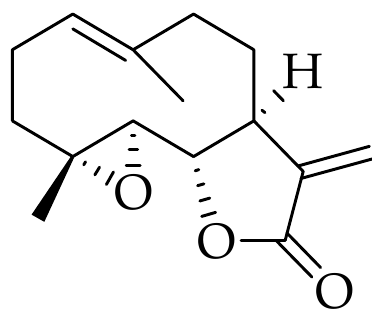
Figure 8. The chemical structure of parthenolide.